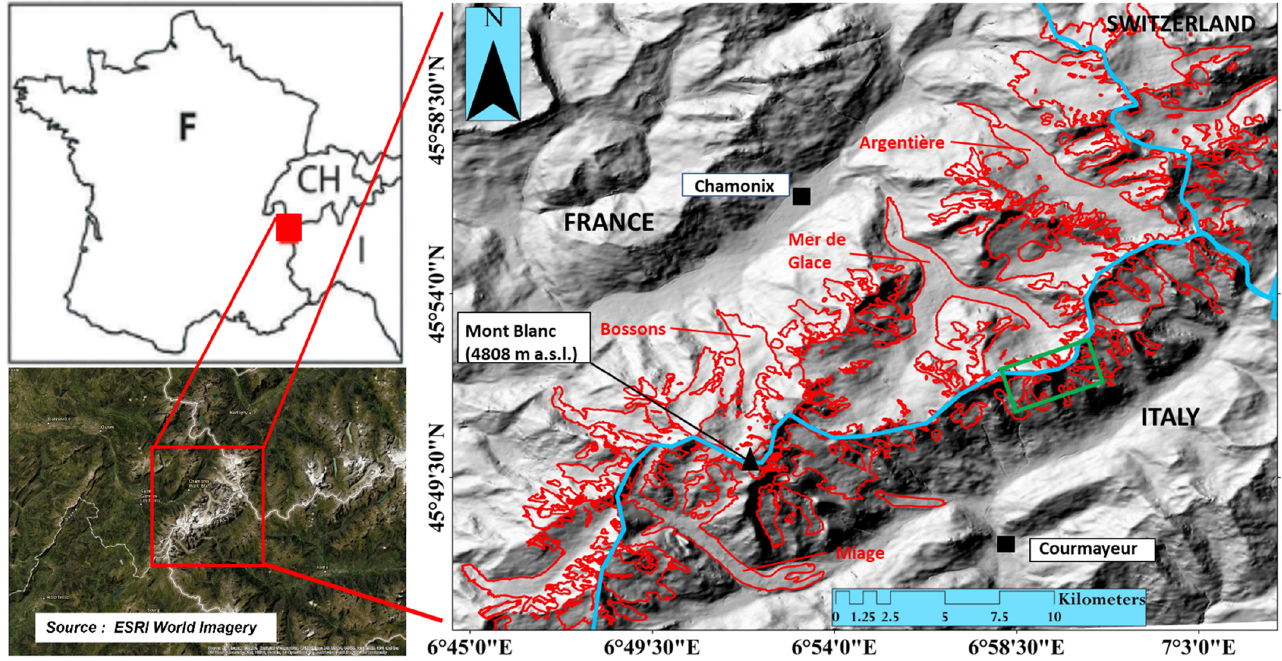
Figure 1. The Mont Blanc massif (MBM; Western European Alps). The hill shade is generated from the Pleiades digital elevation model (DEM), and the glacier outlines (in red) depicted are mapped from this study. The blue line shows the boundary between France, Italy, and Switzerland. The green box shows the area shown in Figure 2.